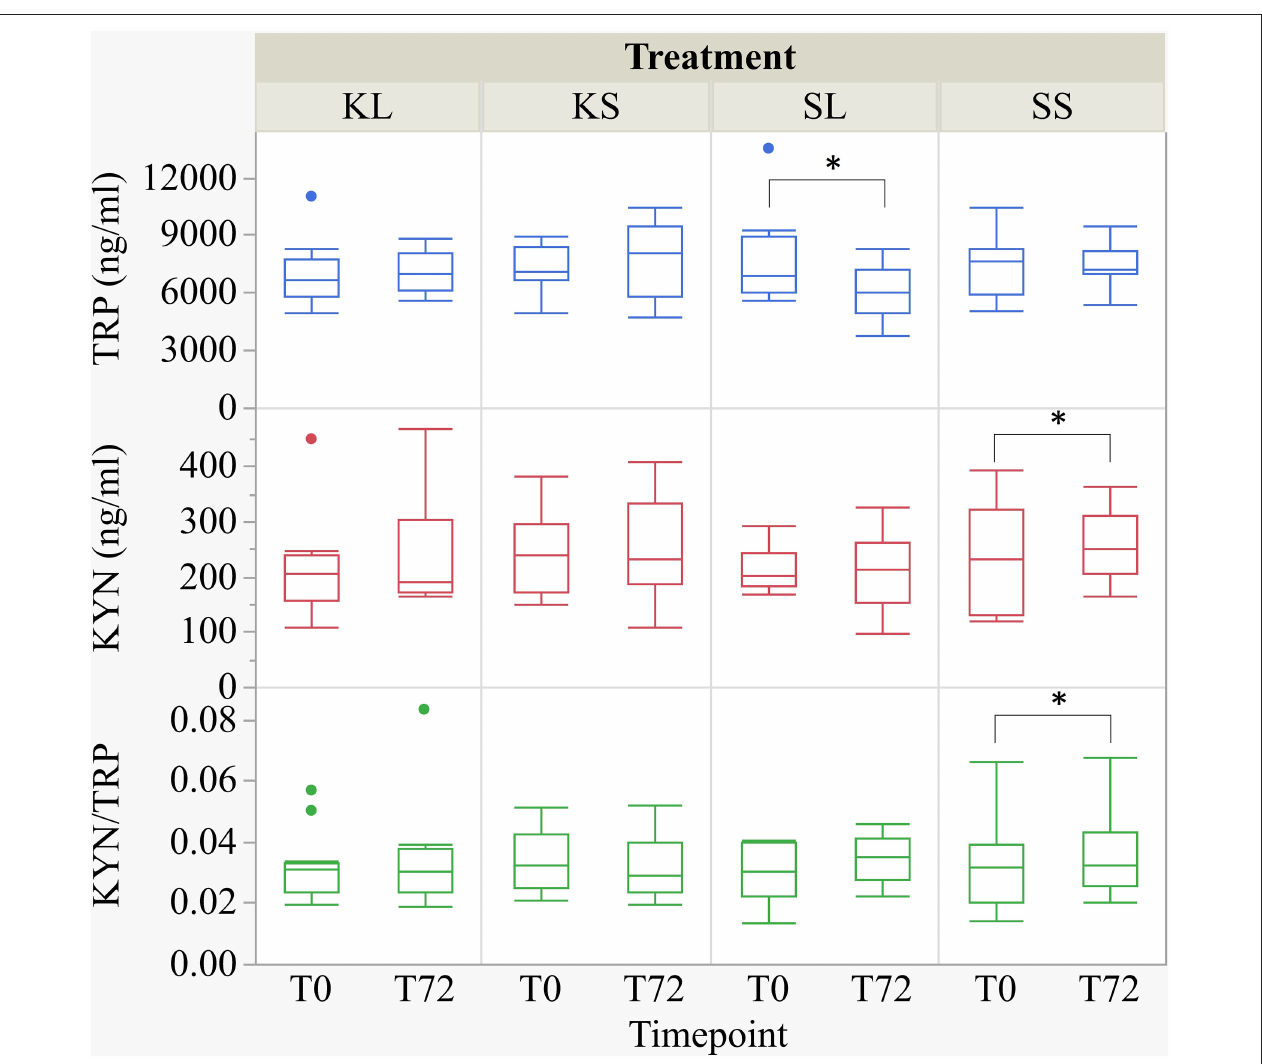
FIGURE 4 | Tryptophan (ng ml − 1 ), kynurenine (ng ml − 1 ), and kynurenine–tryptophan ratio in pig plasma at baseline and at 72h after the injection with ketoprofen–lipopolysaccharide (LPS), ketoprofen–saline, saline–LPS, and saline–saline. Turnover rates were calculated based on moles per milligram of the respective analyte. Round dots indicate outliers. Significant differences of planned comparisons between sampling time points ( p < 0.05) are marked with an asterisk.